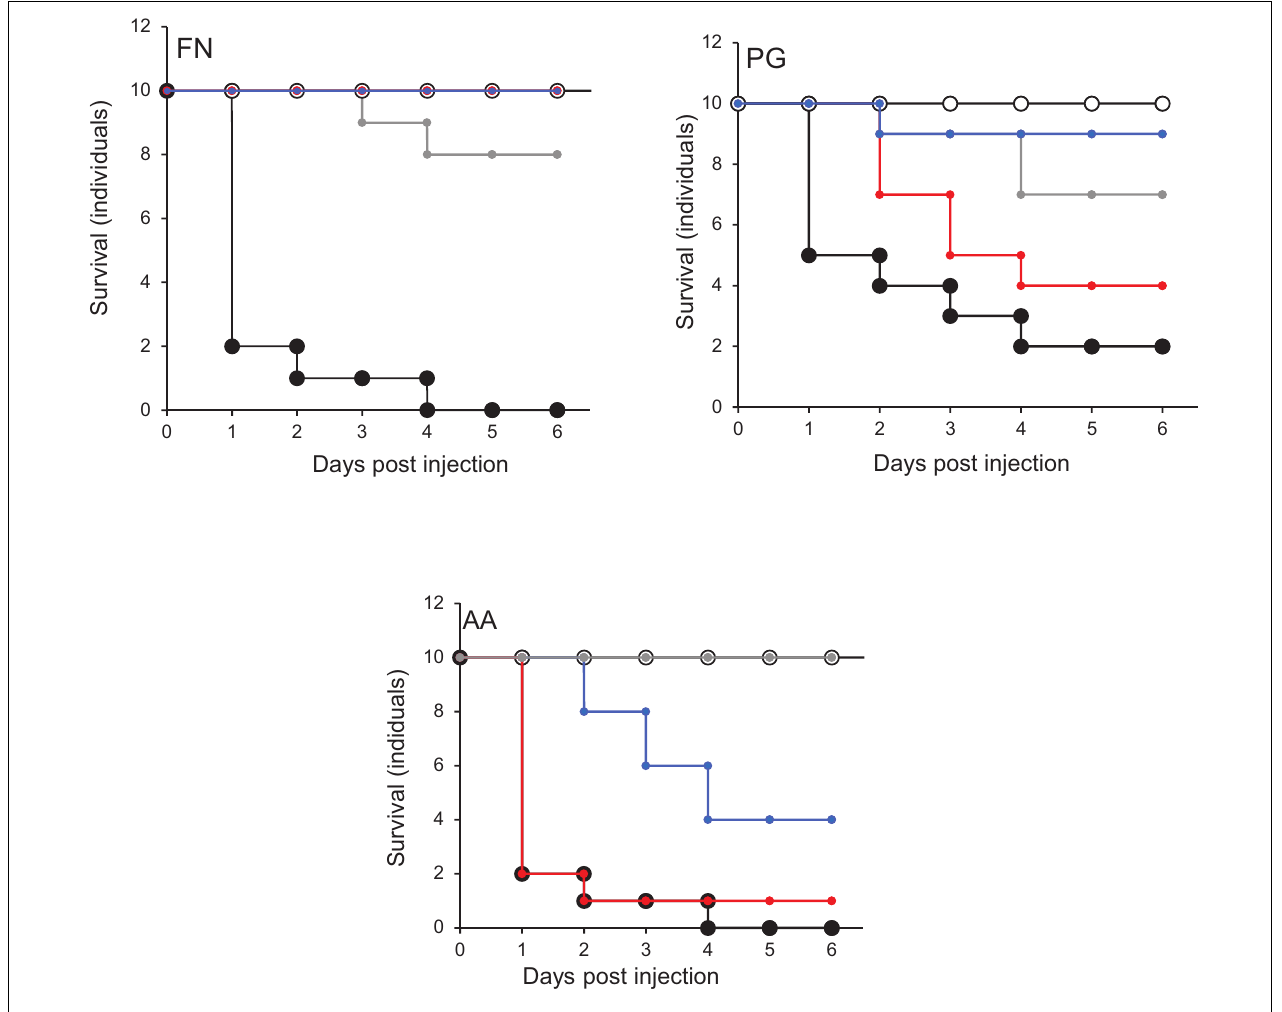
FIGURE 7 | Protection of larvae conferred by prior inoculation with candidate probiotics and administration of periodontal pathogens 24 h later, into the different larval prolegs. Pathogen only (black symbols) and PBS (white symbols). L. rhamnosus (gray symbols), L. reuteri (red symbols), or S. salivarius (blue symbols). All experiments were done twice on 2 consecutive weeks, with different batches of larvae and with three replica plates where each plate contains 10 larvae. Prior-injection of larvae with L. rhamnosus GG or S. salivarius K-12 was highly protective against F. nucleatum . L. reuteri had the most effective protection against the effects of P. gingivalis, while S. salivarius afforded the greatest protective effect against A. actinomycetamcomitans